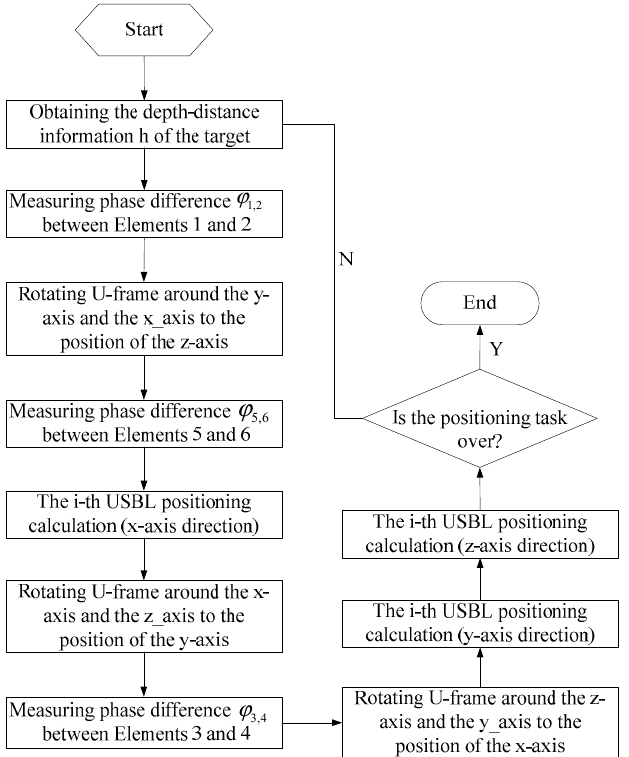
Figure 7. The flow chart of the USBL positioning calculation model based on the rotating array and reusing elements.